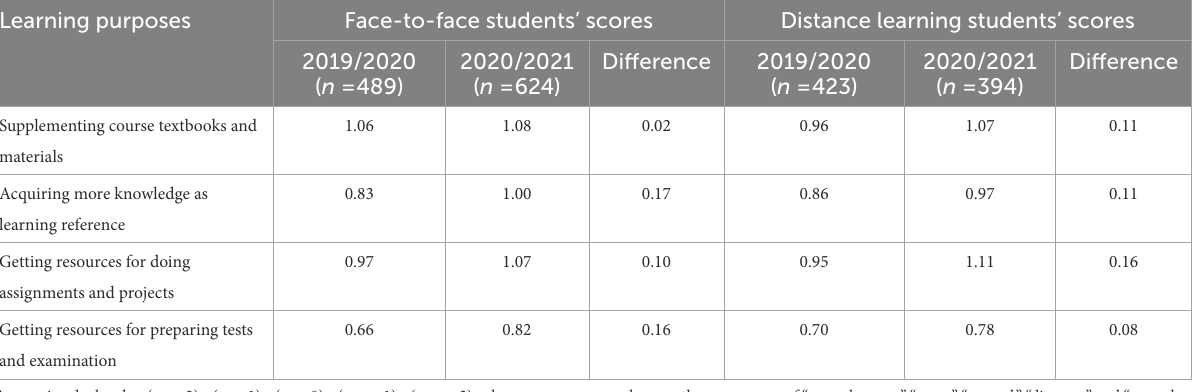
TABLE 1 Overall usefulness of OER for various learning